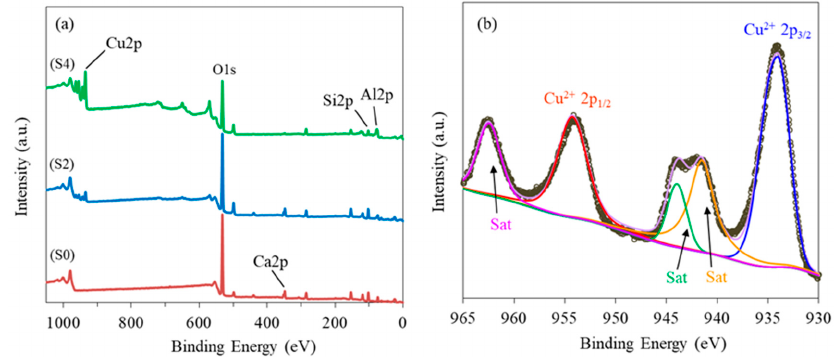
Figure 3. XPS spectra of S0, S2 and S4 samples: ( a ) survey; ( b ) Cu 2p.